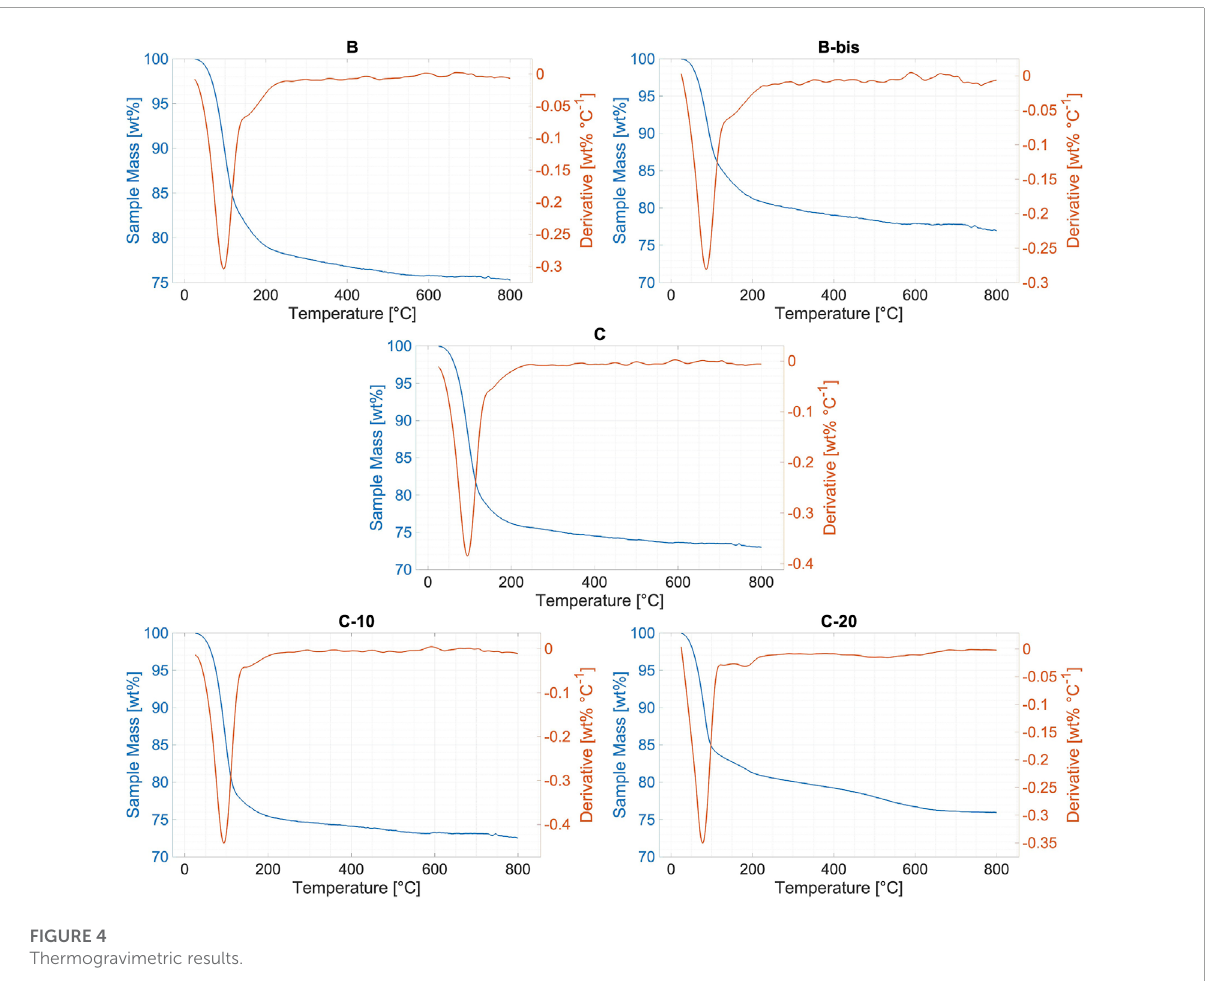
FIGURE 4 Thermogravimetric results.